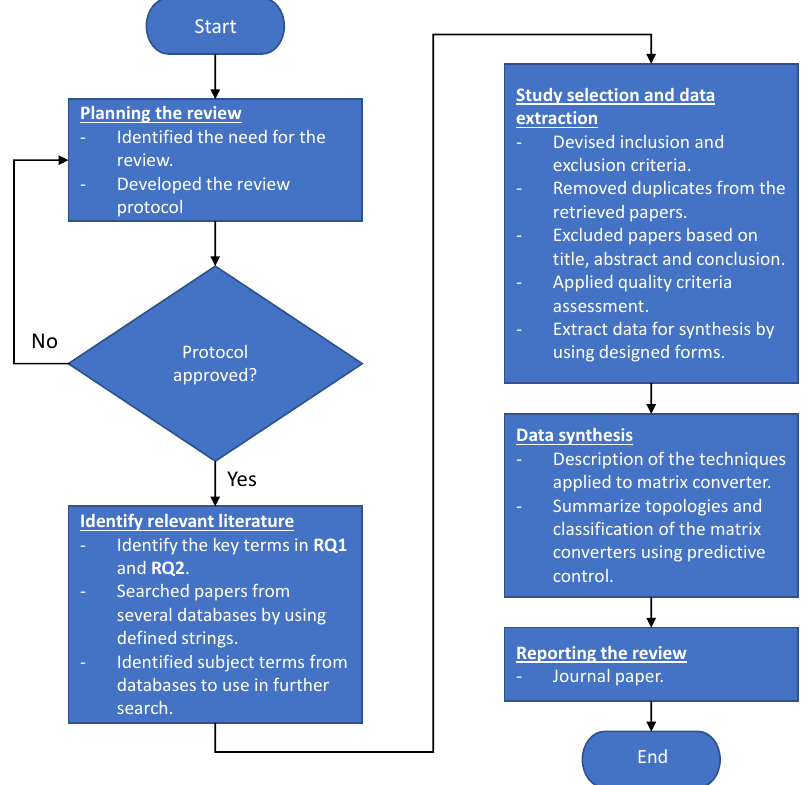
Figure 1. Systematic literature review procedure